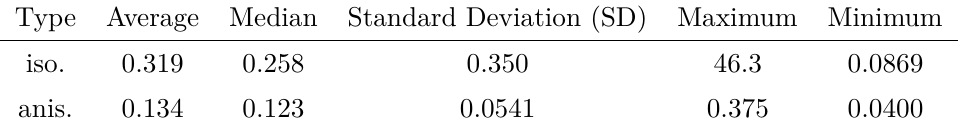
Table 4 . Statistical Data of c for SUSY AdS vacua with α = 1 / 2 for the isotropic (iso.) and anistropic (anis.)